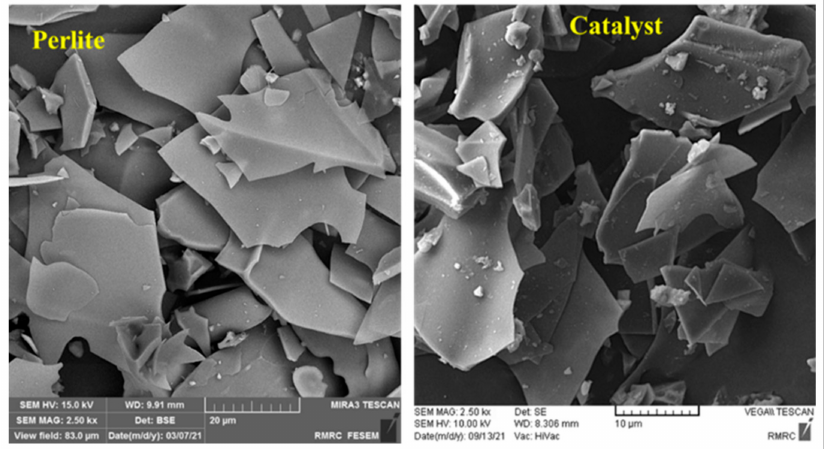
Figure 2. SEM images of Per and the as-prepared catalyst.